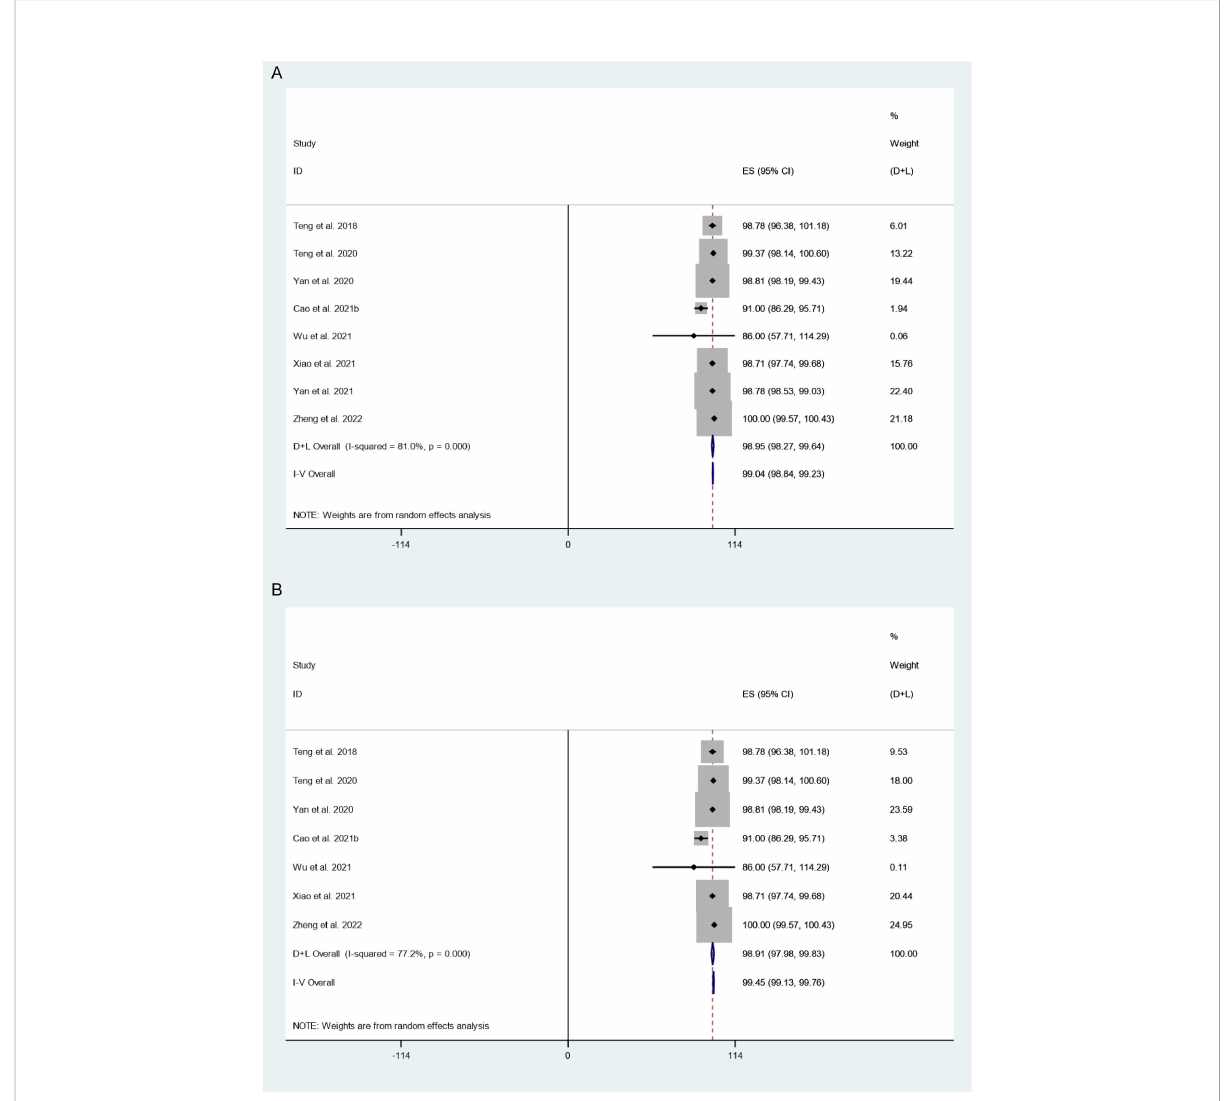
FIGURE 4 VRR after thermal ablation at 3-year follow-up (A) Before sensitivity analysis; (B) After sensitivity